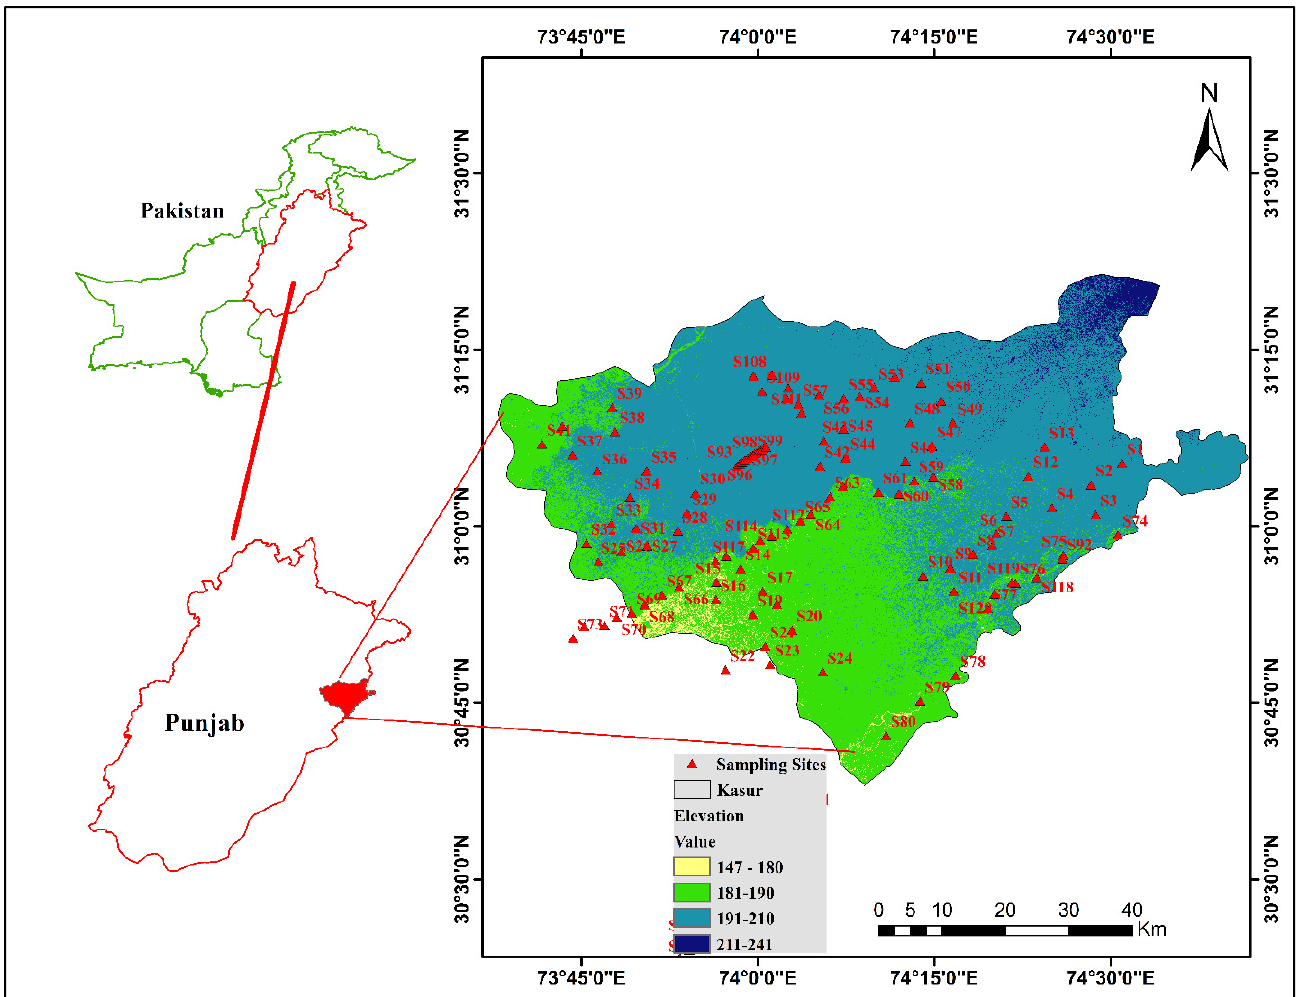
Figure 1. Study area with elevation and sampling location in the various ecosystem (riparian ecosystem, wetland ecosystem, urban ecosystem, forest ecosystem, and agro-ecosystem).